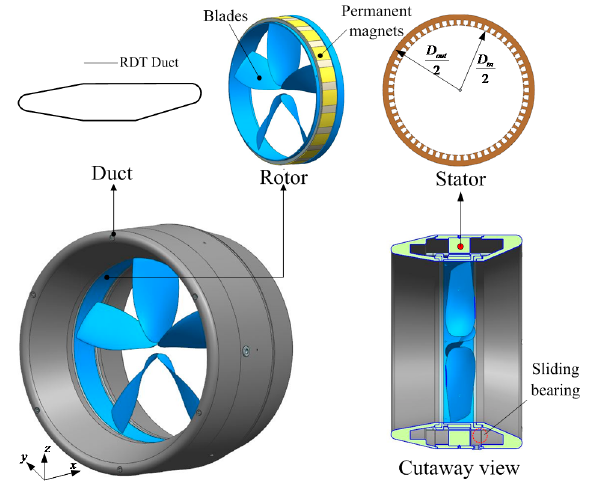
Figure 1. Structure of RDT.